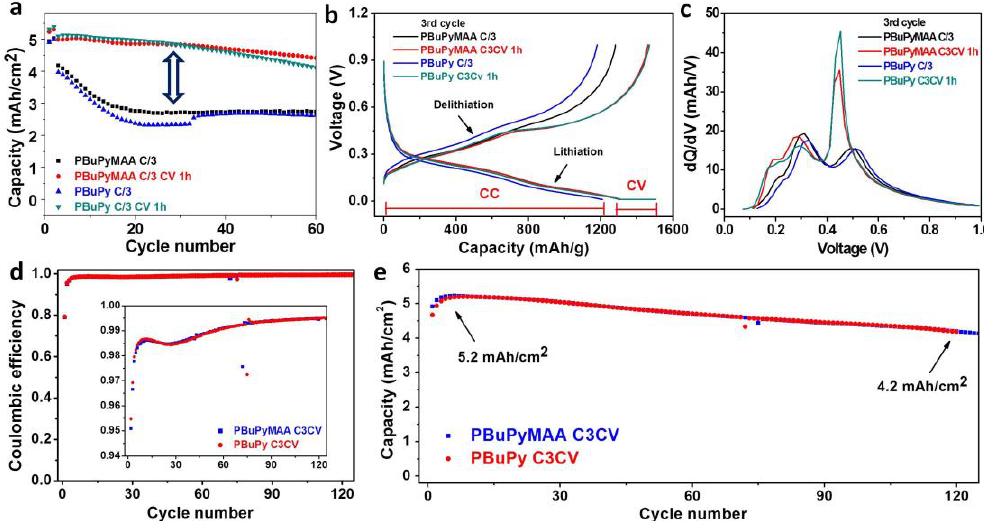
Figure 3. Cycling performance of PBuPy and PBuPyMAA cells. ( a ) areal capacity; ( b ) Voltage-capacity profile at the 3rd cycle; ( c ) dQ/dV vs. voltage diagram of delithiation process at the 3rd cycle of cells under C/3 and C/3 with constant voltage (CV) 1 h procedures; ( d ) coulombic efficiency and ( e ) areal capacity under C/3 with CV till a cut-off current of C/50. (1C = 1 A/g).